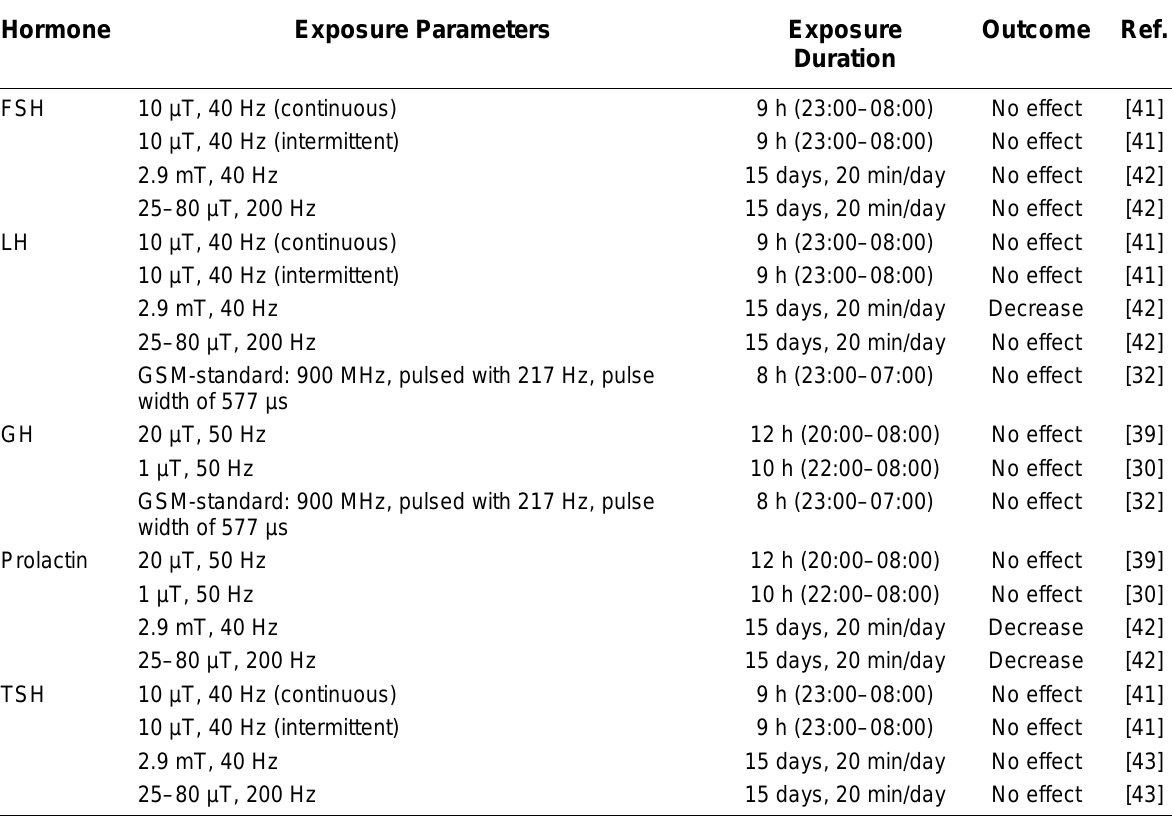
Effects of Electromagnetic Fields on Concentrations of Various Hormones Hormone Exposure Parameters